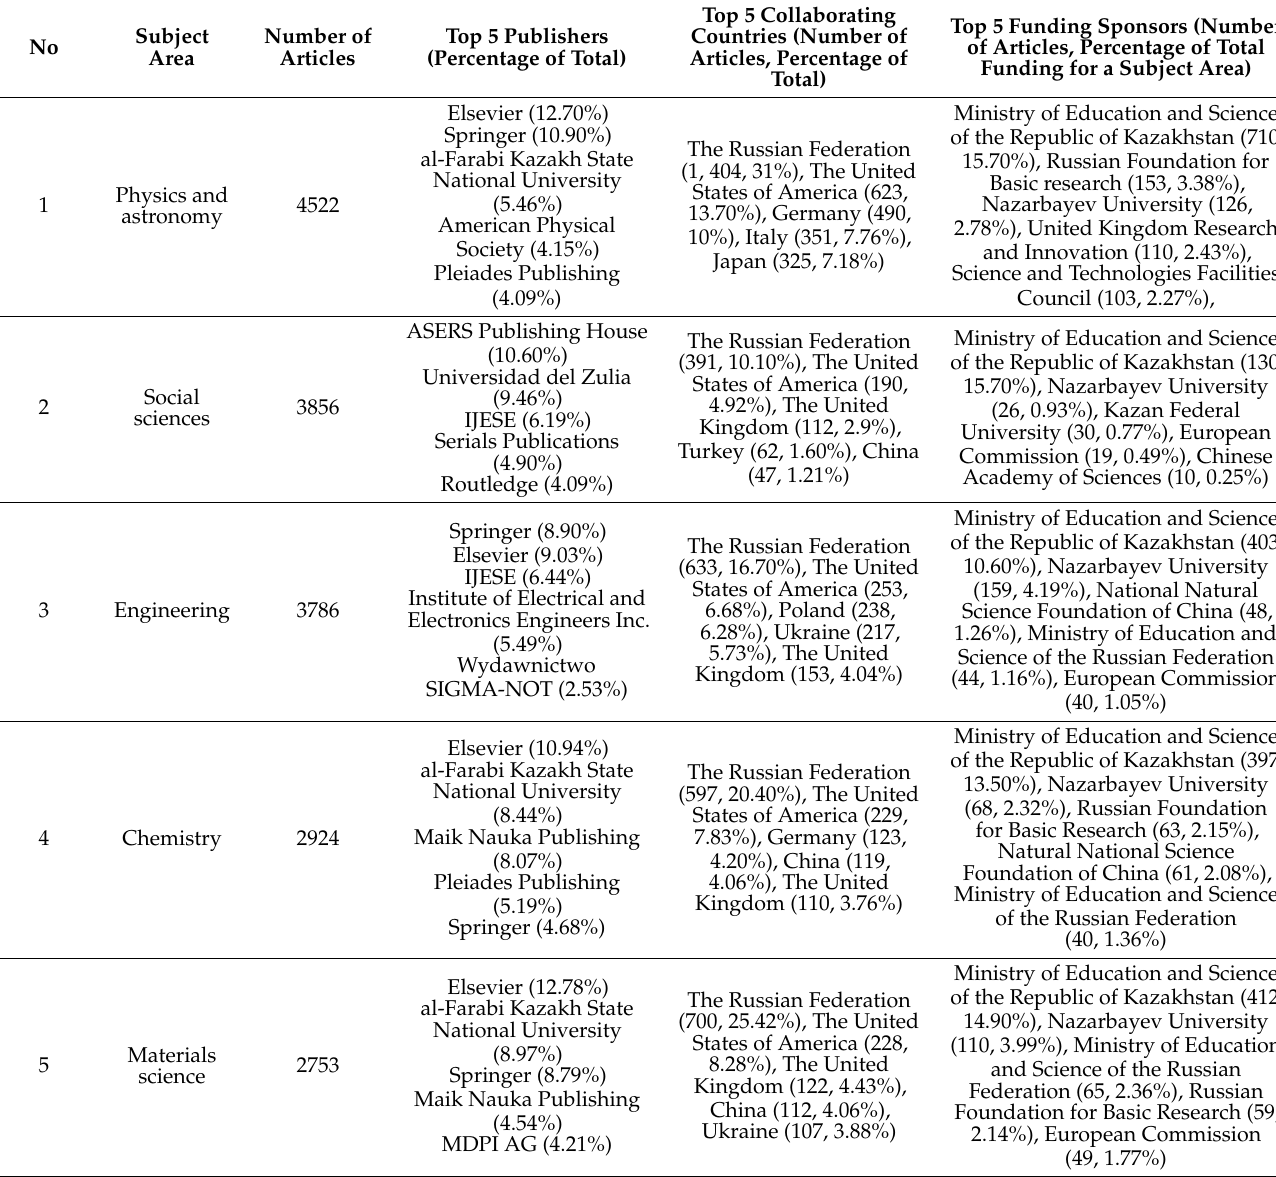
Table 3. Top 5 publishers, collaborating countries, and funding sponsors of the top 5 subject